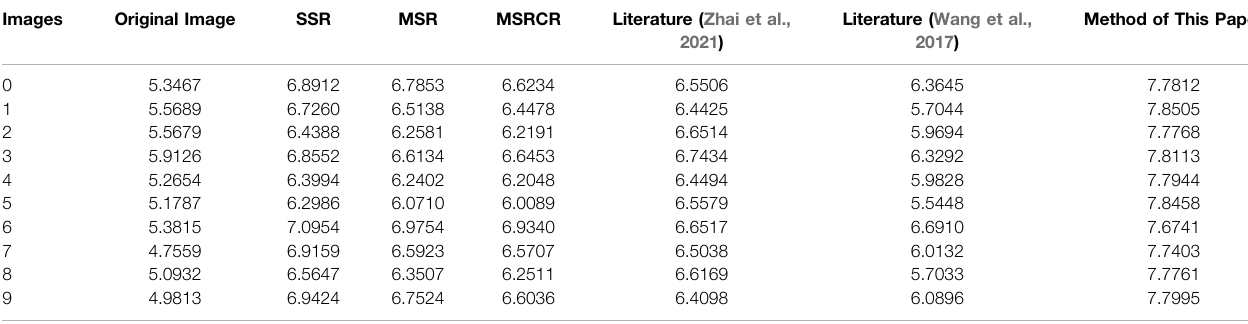
TABLE 4 | IE of low-illumination image enhancement with different algorithms. Images Original Image